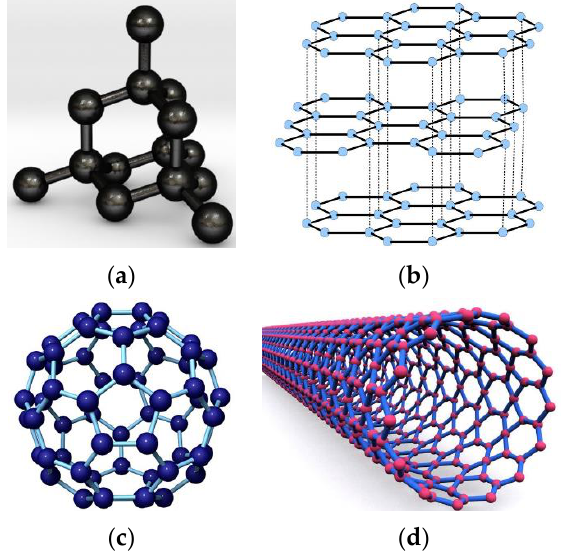
Figure 6. Structure of diamond ( a ), graphite ( b ), fullerene ( c ), and nanotube ( d ). These images by unknown author are licensed under CC BY.